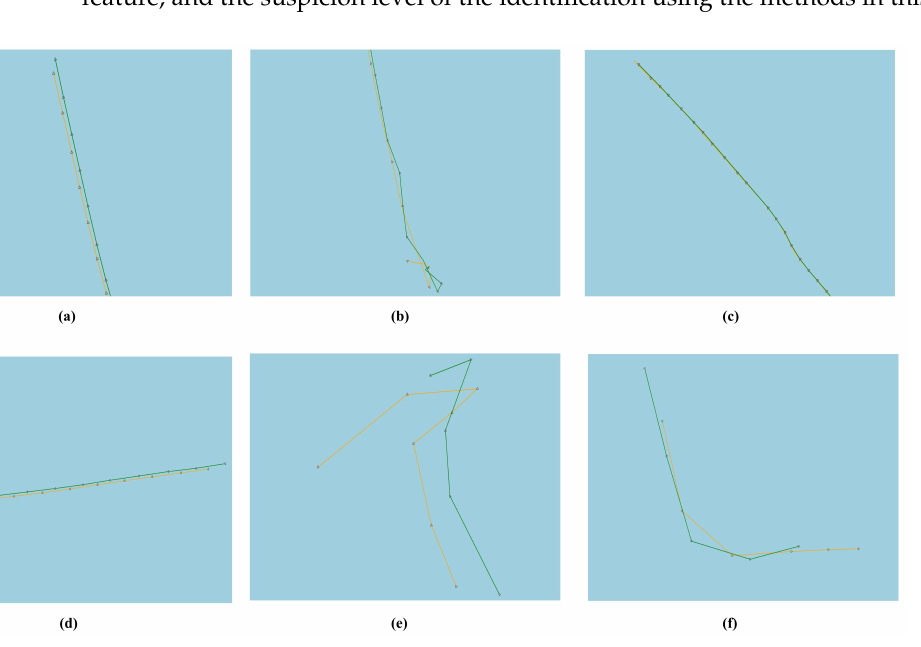
Figure 11. The trajectory of legal transshipment events, ( a – f ) correspond to events No. 1–6. Table 13. The features and identification results of legal transshipment events.